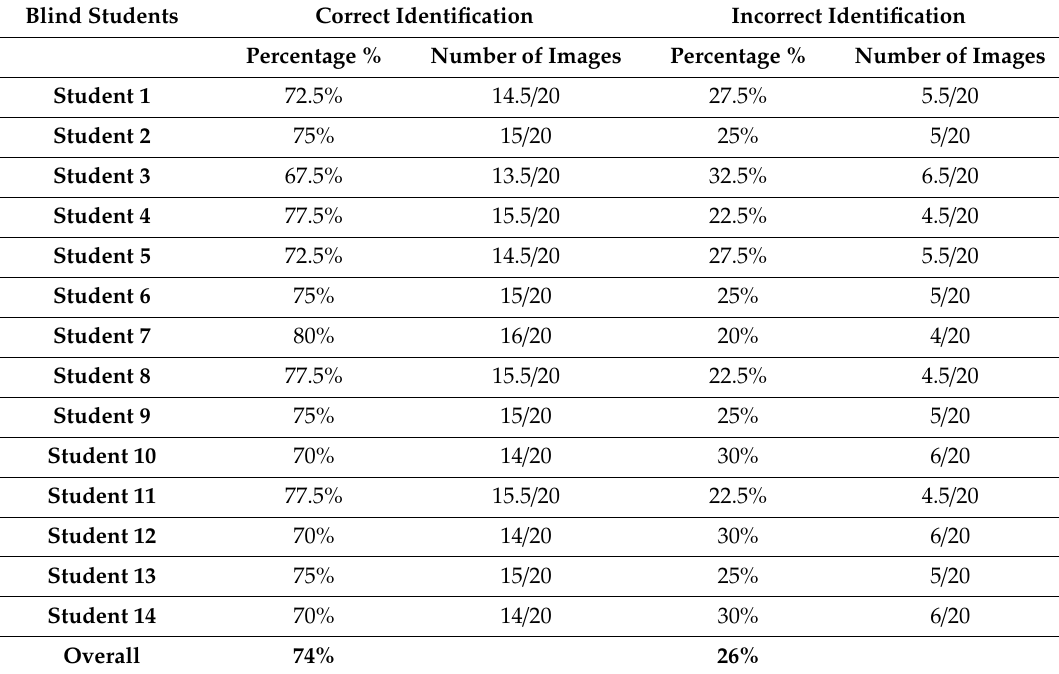
Figure 13. The visually impaired students of the boarding school who perceived visual information using tactile graphics. Table 4. The results of the experimental process of perceiving tactile graphics. Blind